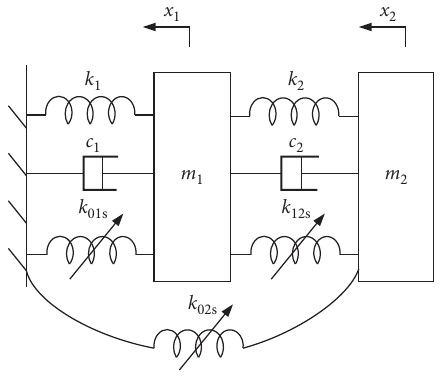
Figure 7: A 2-DOF model with